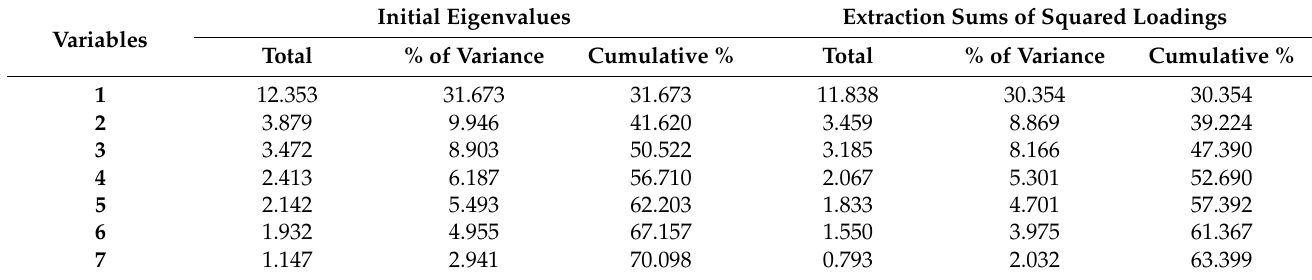
Table 11. Eigenvalues and cumulative